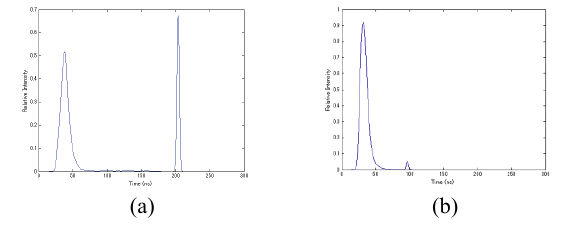
Figure 2 is the echo signals of scenario no.1 and no.13, respectively. As a result of analysis of the echo signals, the first peak corresponded to surface of object and the second peak corresponded to the ground.